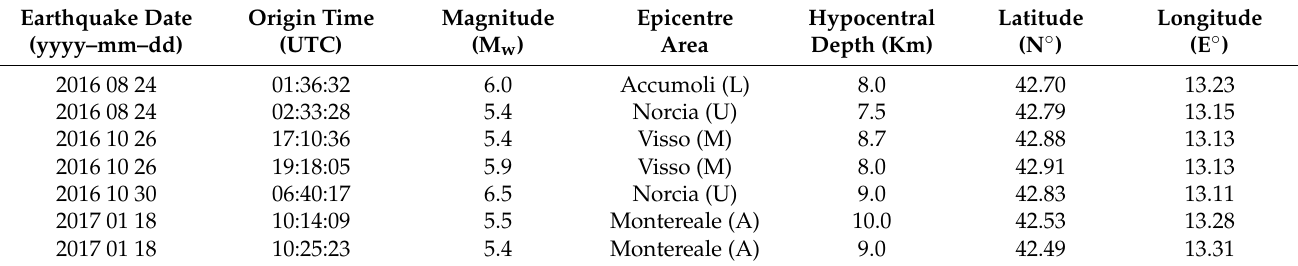
Table 1. Parameters of the main seismic events of the earthquake swarm.